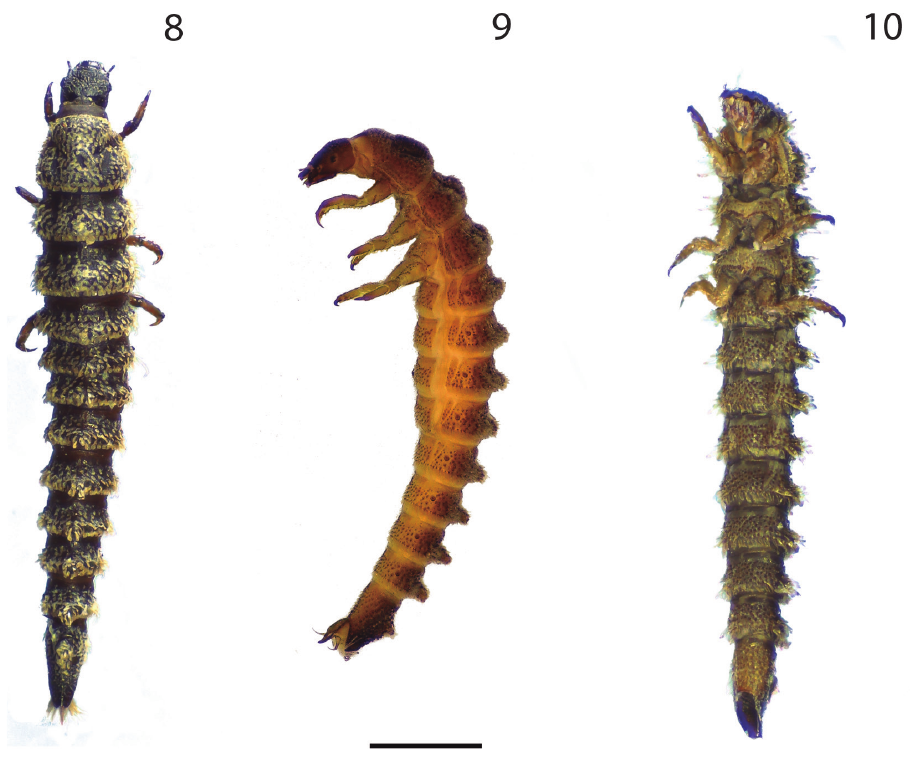
Figures 8–10 - Stethemis shepardi mature larva, habitus. ( 8 ) dorsal view; ( 9 ) lateral view; ( 10 ) ventral view. Scale bar: Figs. 8–10: 1 mm.